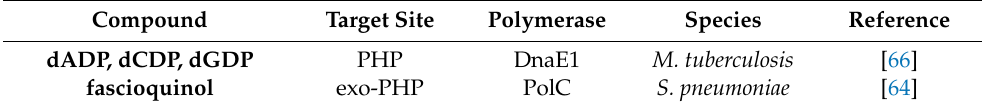
Table 2. Bacterial replicative exonuclease